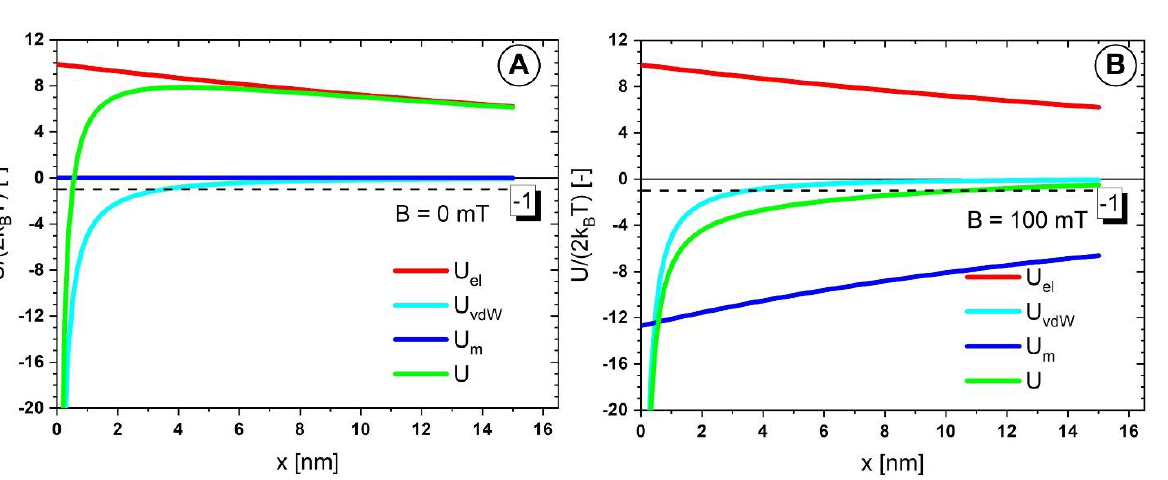
Figure 14. Electrostatic repulsion energy (red line), Van der Waals energy (blue), magnetic dipole- dipole energy (cyan), and resultant energy (green line) for ( A ) B = 0 mT, and ( B ) B = 100 mT. At B = 0 mT, the electrostatic repulsion dominates the interaction. No spontaneous clustering should occur provided that the shell thickness is at least 0.5 nm. For x > 0.5 nm the resultant energy exceeds the stability threshold of −1 (Figure 14A).